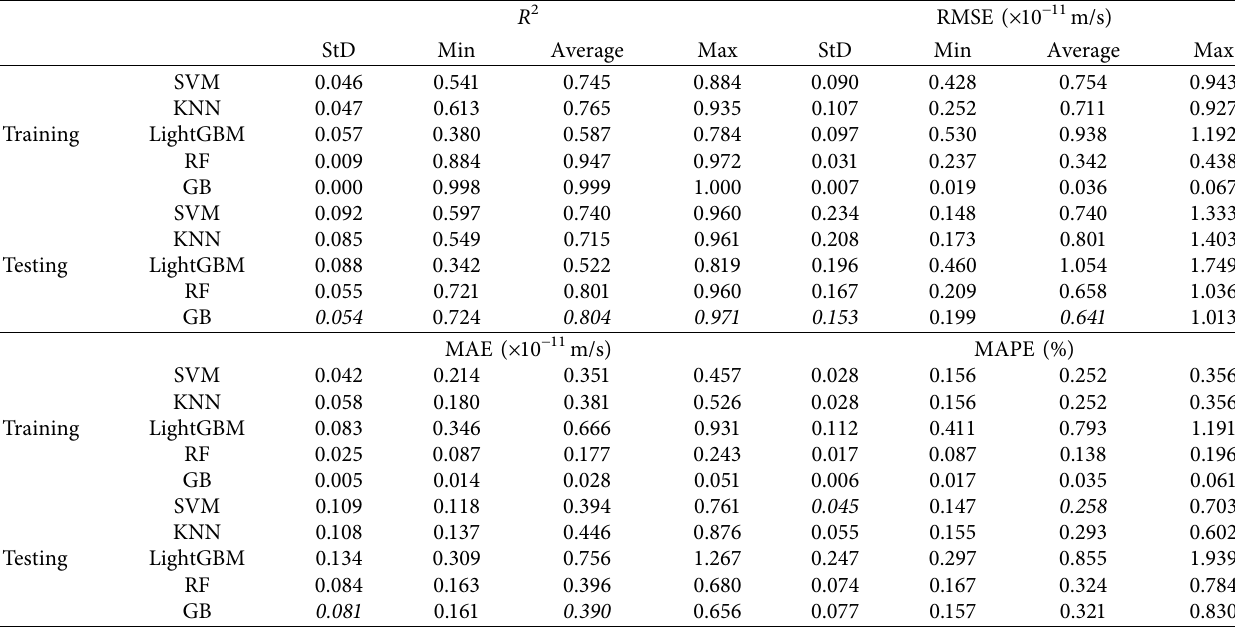
Table 3: Min, max, average, and StD of performance values of 10000 performance values.